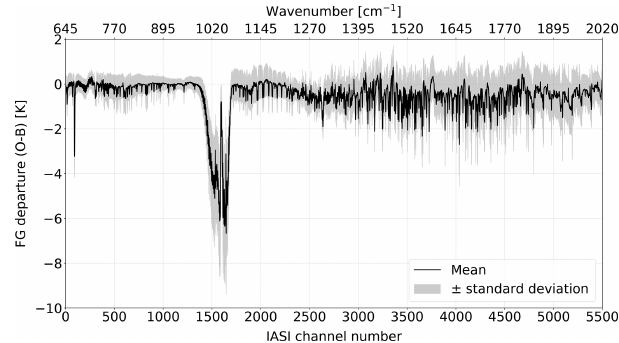
Figure 4. Mean ± standard deviation of FG departures with respect to 5499 IASI channel number and wavenumber (cm − 1 ) (bands 1 and 2 without channel 1194) over the set of 6123 atmospheric pro-